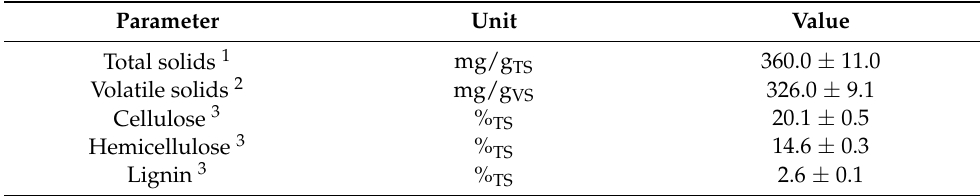
Table 2. Characteristics of the maize silage used in the